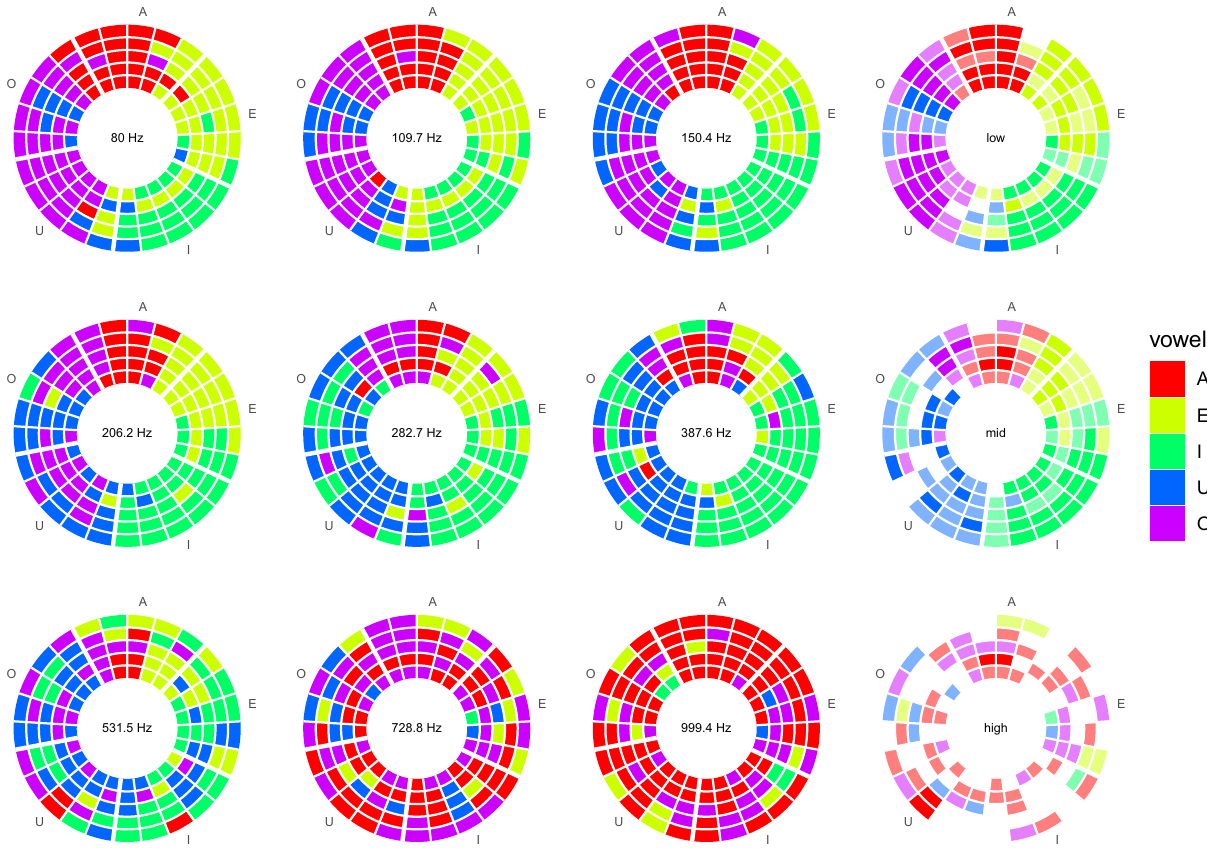
Figure 3. Result of the vowel labeling experiment of the VTP space, discretized into 1125 cells, each cell being labeled by one participant. The five concentric rings represent the five voice types, from bass (inner ring) to soprano (outer ring). The vowels are arranged along the circular dimension. Three leftmost columns: Reported vowels on nine slices of the VTP space, for pitches set to 80.0, 109.7, 150.4, 206.2, 282.7, 387.6, 531.5, 728.8, 999.4 Hz ; Rightmost column: Prevalent reported vowels for low (80–150.4 Hz), medium (206.2–387.6 Hz), and high (531.5–999.4 Hz) pitches, full saturation representing perfect agreement, and white representing maximal